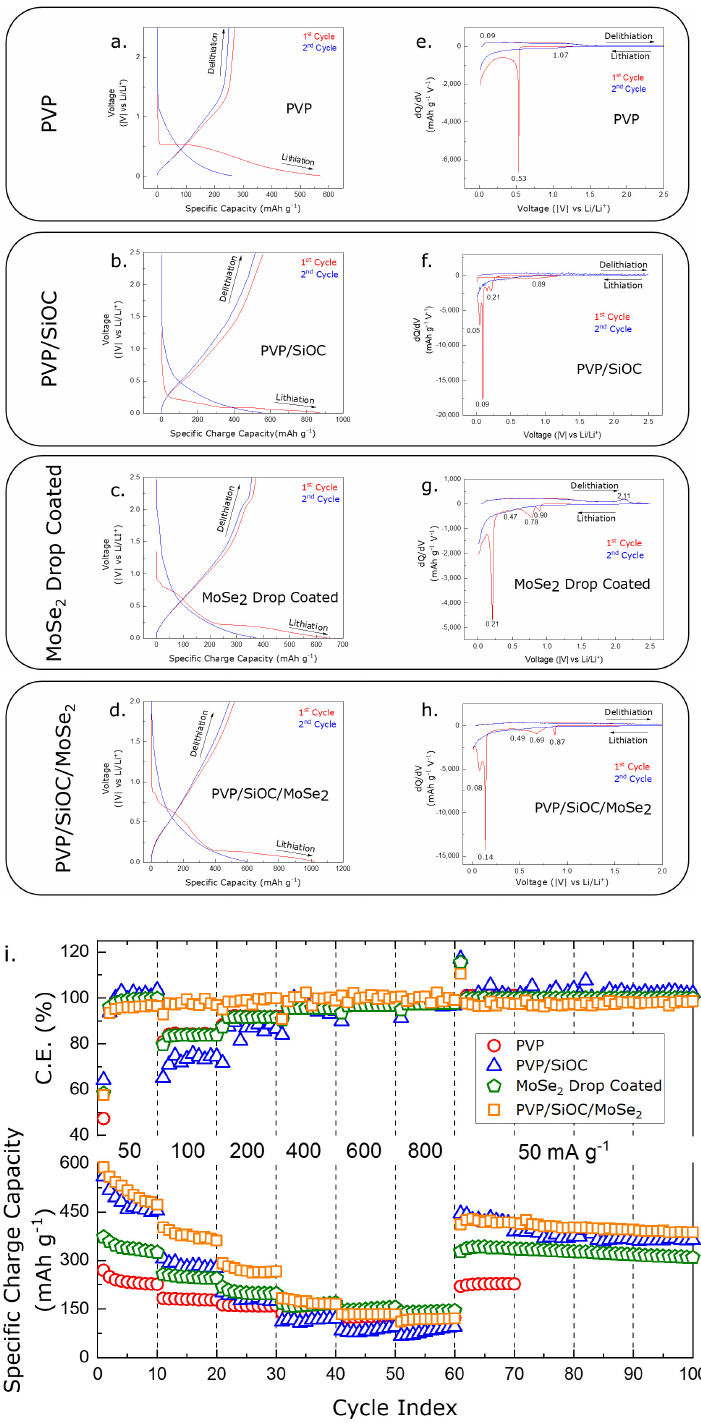
Figure 8. Charge–discharge profile of ( a ) PVP fiber mat electrode; ( b ) PVP/SiOC fiber mat electrode; ( c ) MoSe 2 drop coated fiber mat electrode; ( d ) PVP/SiOC/MoSe 2 electrode and differential capacity curves of ( e ) PVP fiber mat electrode; ( f ) PVP/SiOC fiber mat electrode; ( g ) MoSe 2 drop coated fiber mat electrode; ( h ) PVP/SiOC/MoSe 2 electrode; ( i ) cycle performance comparison for PVP, PVP/SiOC, PVP/SiOC/MoSe 2 electrode at different current densities.